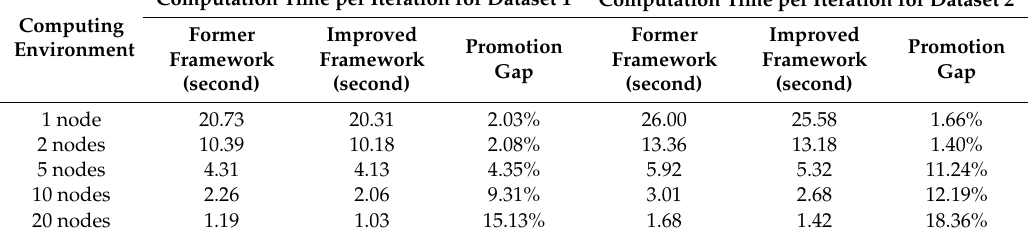
Table 10. E ffi ciency Statistics of the Improved MA-based ABC Framework and the Former Framework Proposed in [17] for Endmember